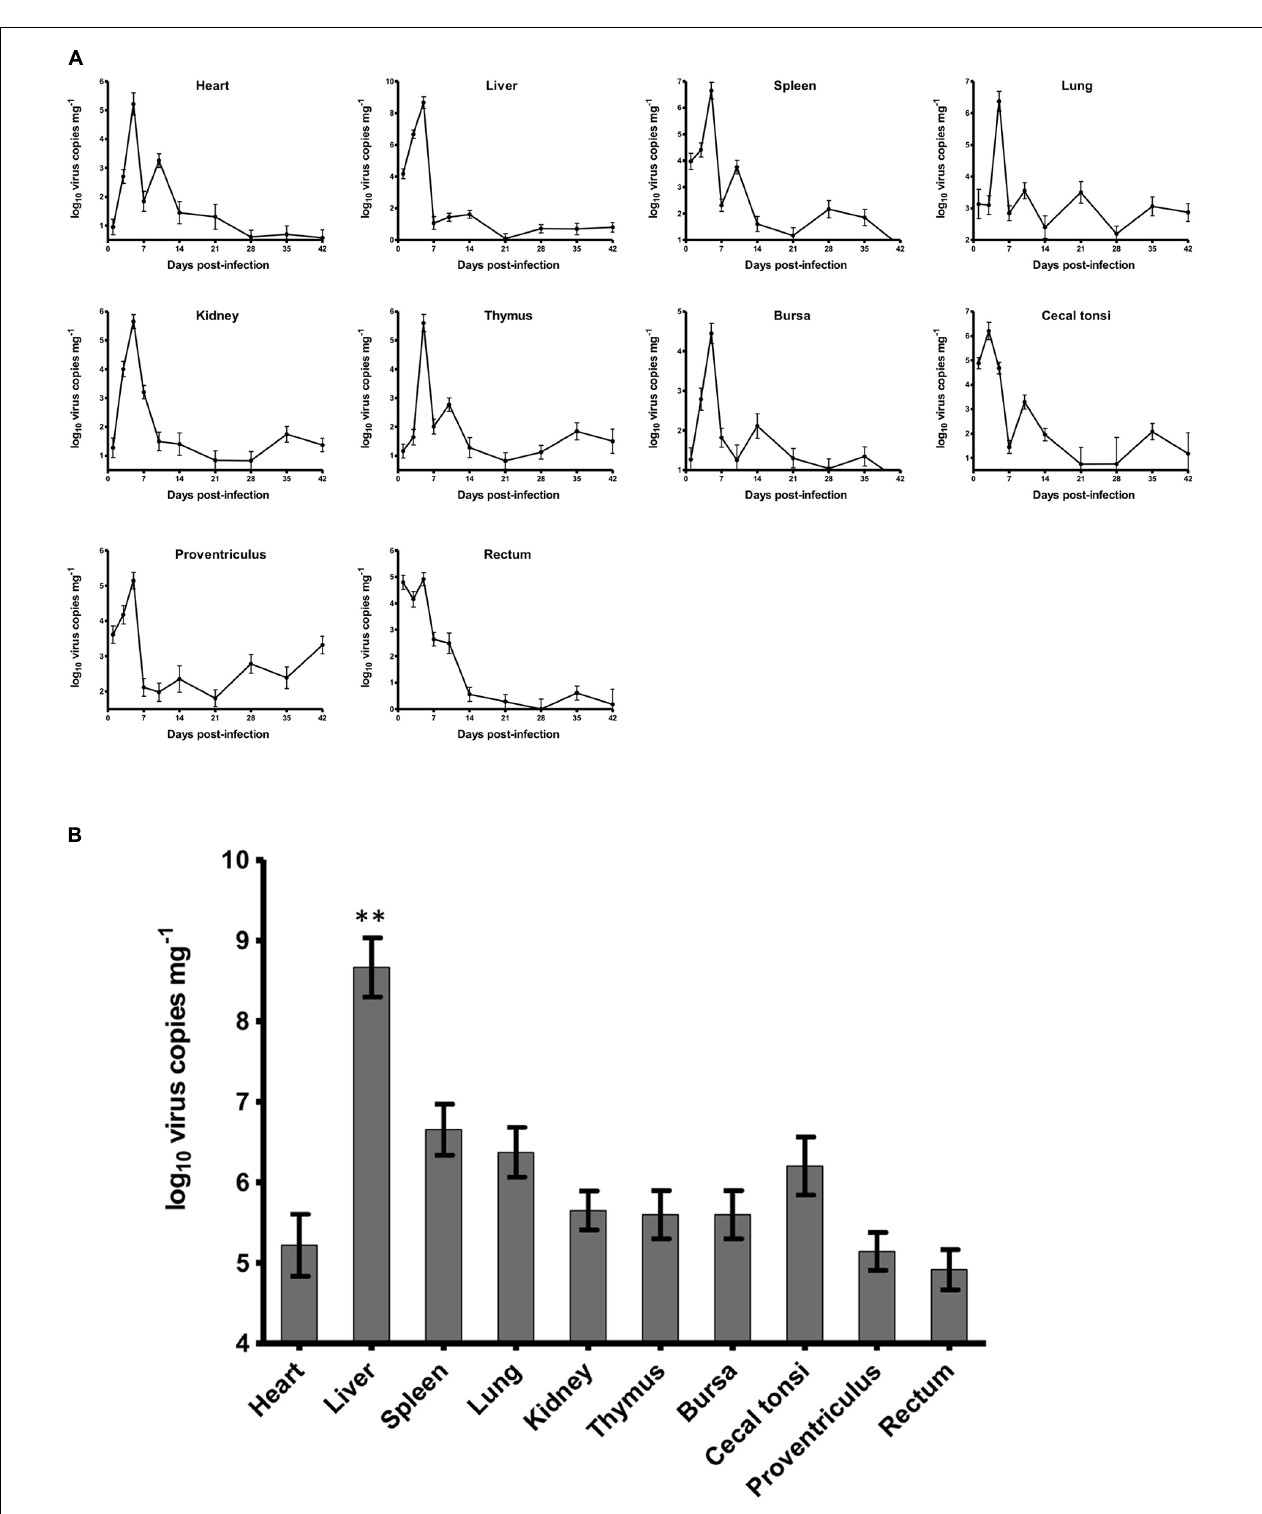
FIGURE 2 | Dynamic distribution of the novel FAdV-4 in experimentally infected SPF chickens. (A) One replication peak occurred in the heart, liver, spleen, lung, kidney, thymus, bursa, proventriculus, and rectum at 5 dpi and in caecal tonsi at 3 dpi. (B) The peak concentration of virus replication in the liver was significantly higher than that in other tissues ( ∗∗ p <